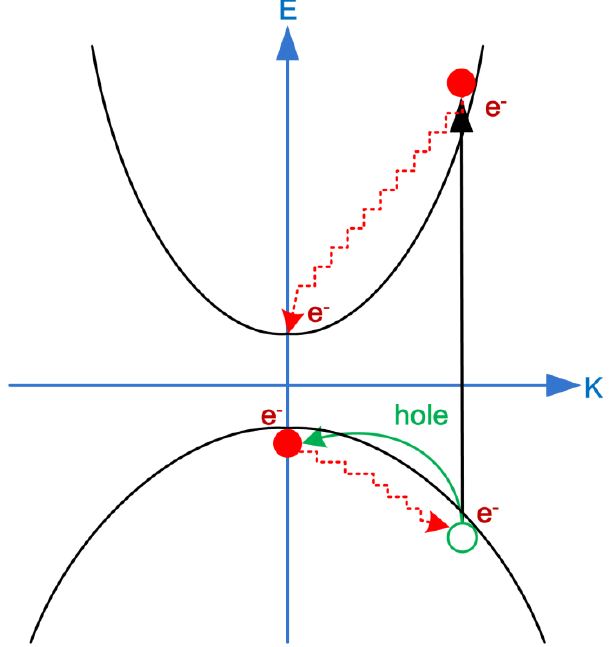
Figure 4. Energy diagram of hot-hole and hot-electron relaxations.